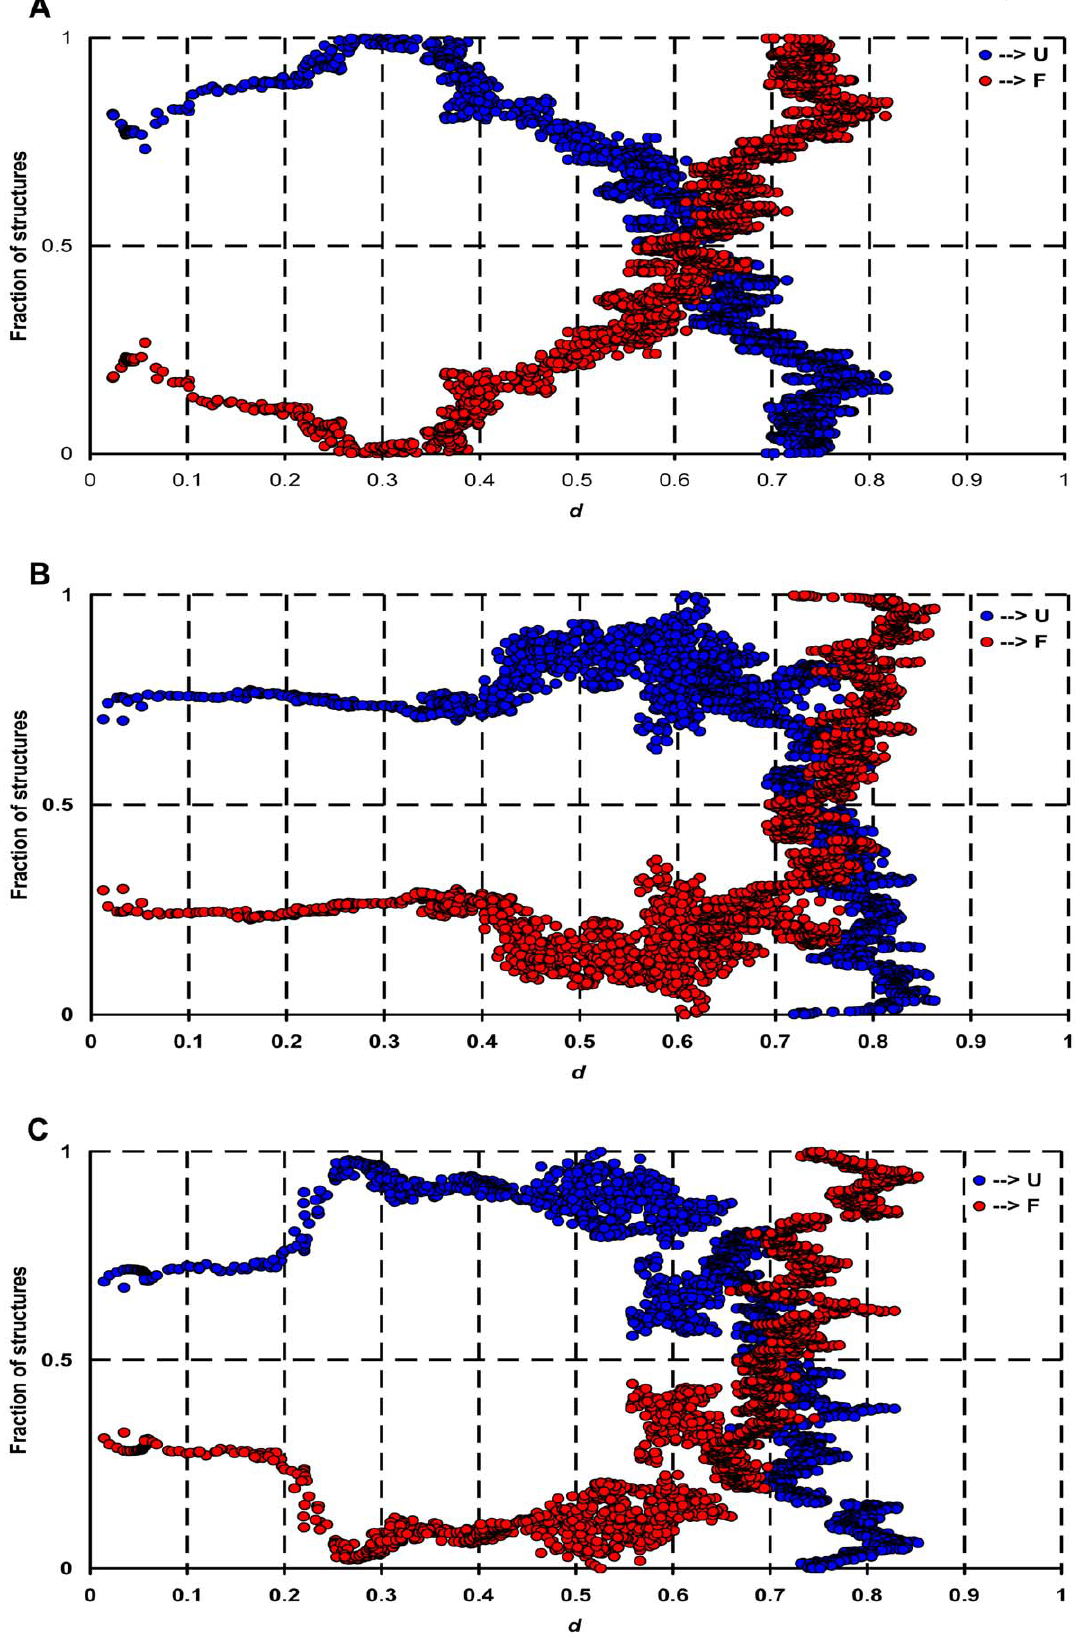
Figure 7. The maximal stability of PHD2 species. The fraction of structures which are more folded (red spheres) or more denatured (blue spheres) than the corresponding structure of each d value is represented. The junction of blue and red spheres indicates the position of main transition for (A) a-PHD2, (B) f-PHD2 and (C) fh-PHD2. doi:10.1371/journal.pone.0047061.g007 PLOS ONE |